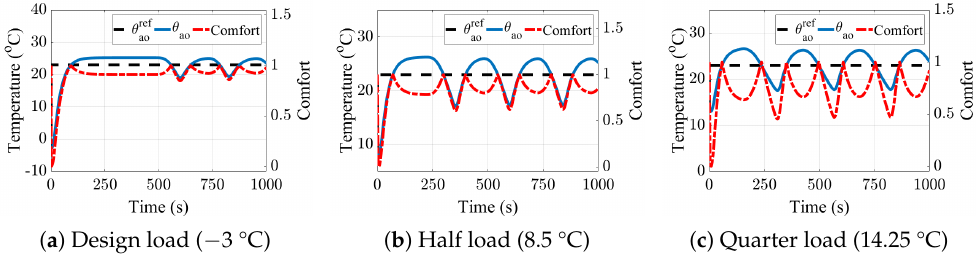
Figure 6. AHU plant response with H ∞ controller at three different thermal load conditions (step